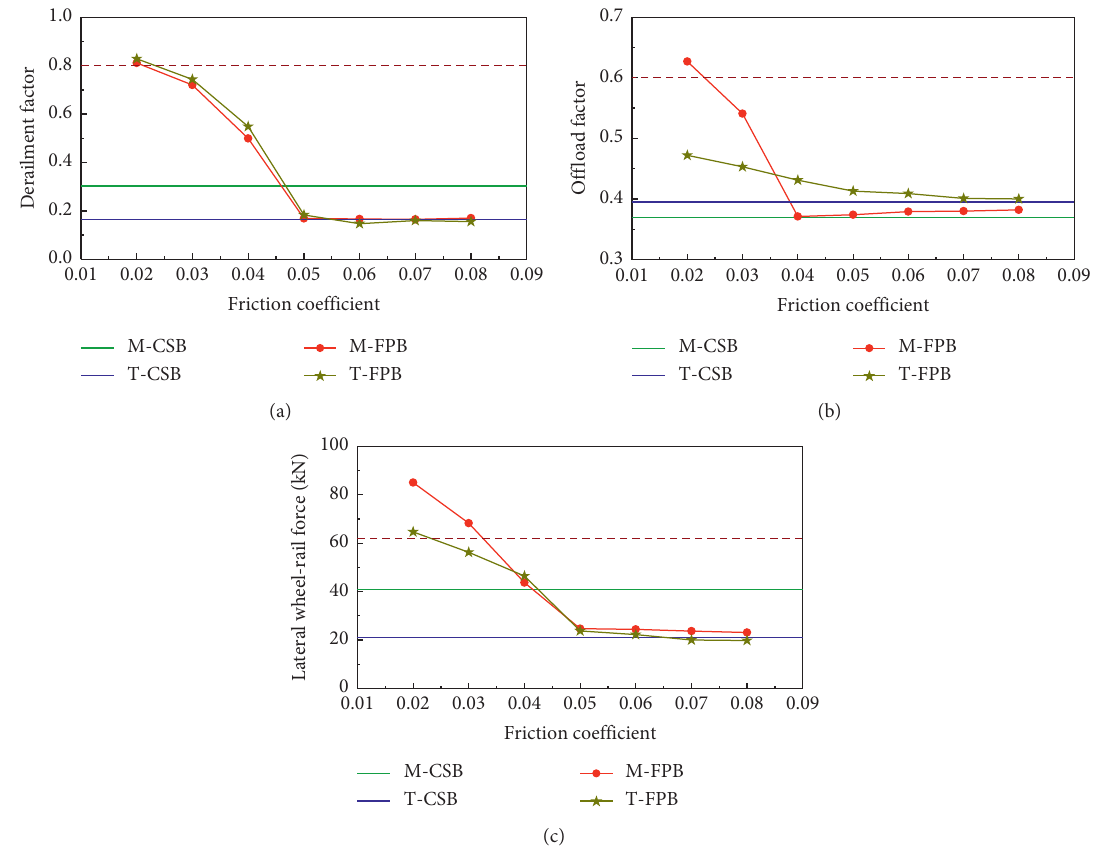
Figure 11: Distributions of running safety indices of the train versus friction coefficient. (a) Derailment factor. (b) Offload factor. (c) Lateral wheel-rail